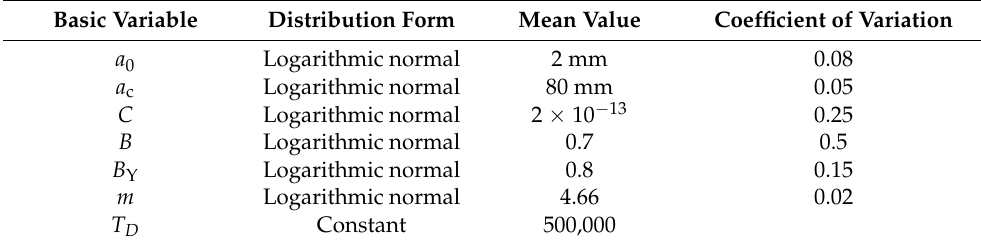
Table 3. Variable values.